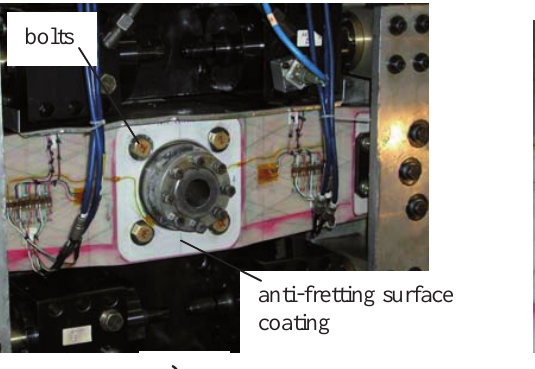
Fig. 3. Component mounted on its test